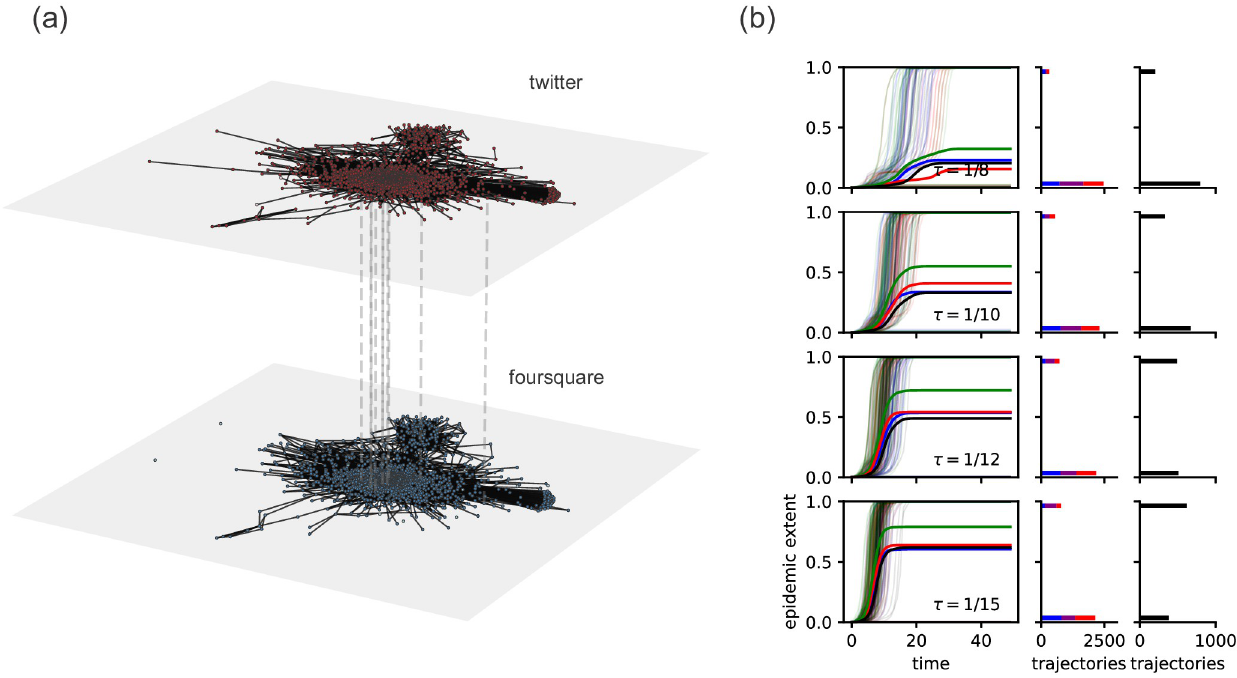
Fig 3. Comparing the epidemic extent for different choices of network data for the JOAPP data set. (a) Network visualization of the JOAPP data set. The dashed lines are not exhaustive, but illustrate that the nodes in each layer are identical. The light colored nodes in each layer are disconnected from the largest connected component in that layer. (b) The threshold model on the JOAPP data. As in Fig 2(b) the left column displays a plot of the epidemic extent with respect to time for the uniplex Twitter network (blue), uniplex Foursquare network (red), the union of uniplex networks (green), and the multiplexed data (black). The thick lines indicate the average epidemic extent and the thin lines are a random sample of 100 individual realizations of this model. The center column illustrates the histogram of epidemic extents for the number of nodes solely accessed from the Twitter network (blue), the Foursquare network (red), and both (magenta). The right column illustrates the distribution of epidemic extents for the multiplexed data.